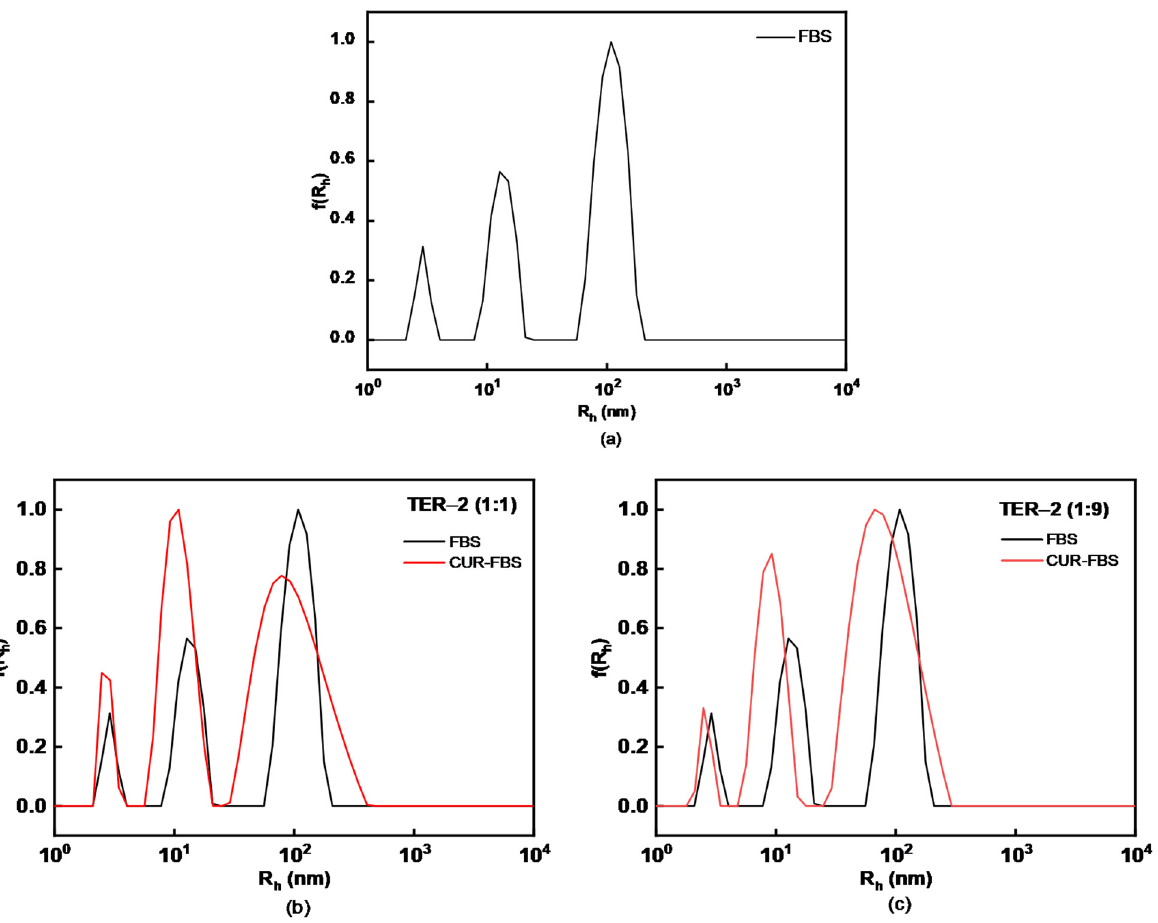
Figure 11. ( a ) Typical CONTIN size distribution of neat FBS, size distributions for ( b ) TER-2/CUR in FBS:PBS 1:1 and ( c ) TER-2/CUR in FBS:PBS 1:9. FBS:PBS 1:1 and ( c ) TER-2/CUR in FBS:PBS